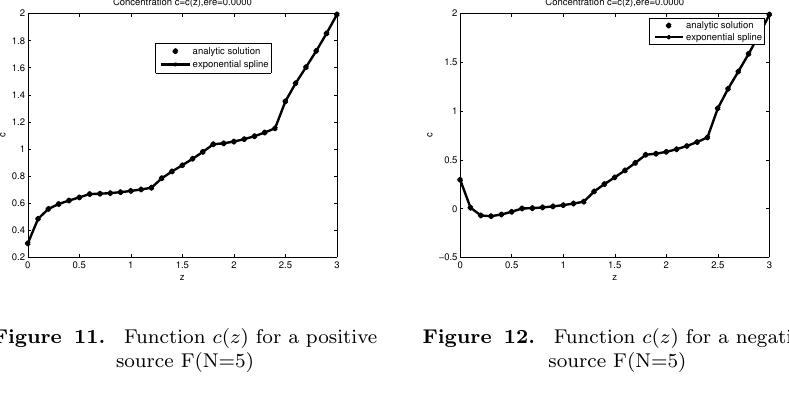
Figure 11. Function c ( z ) for a positive source F(N=5)